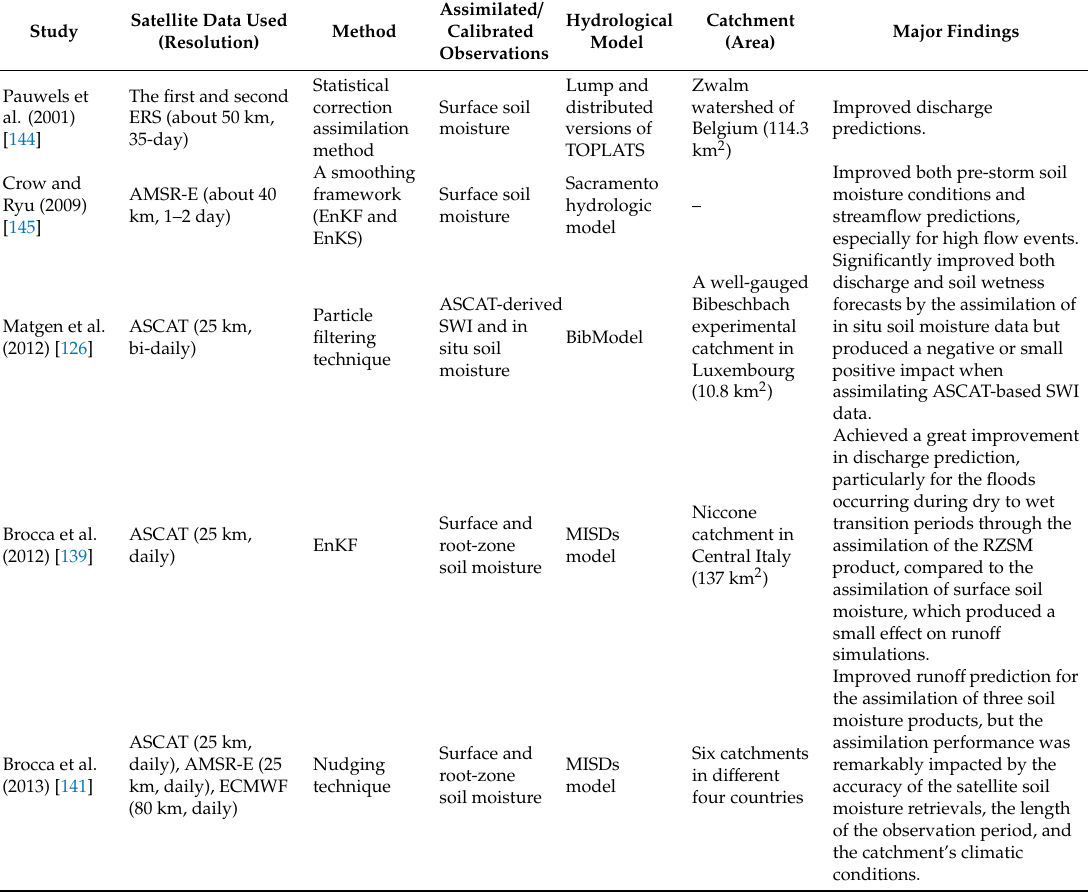
Relevant studies of the applied satellite-based soil moisture data for improving hydrological